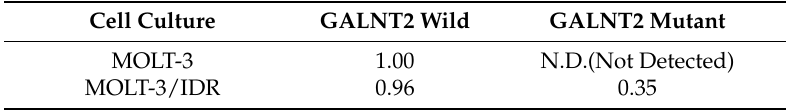
Table 4. GALNT2 mutation expression ratio in MOLT-3/IDR cells relative to MOLT-3 cells.